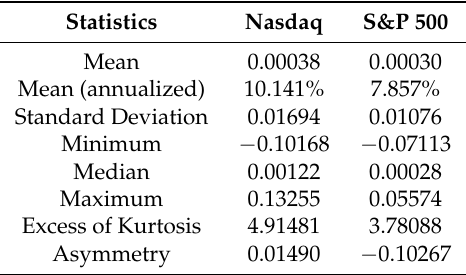
Table 1. Descriptive statistics of daily log-returns of Nasdaq and S&P 500 stock